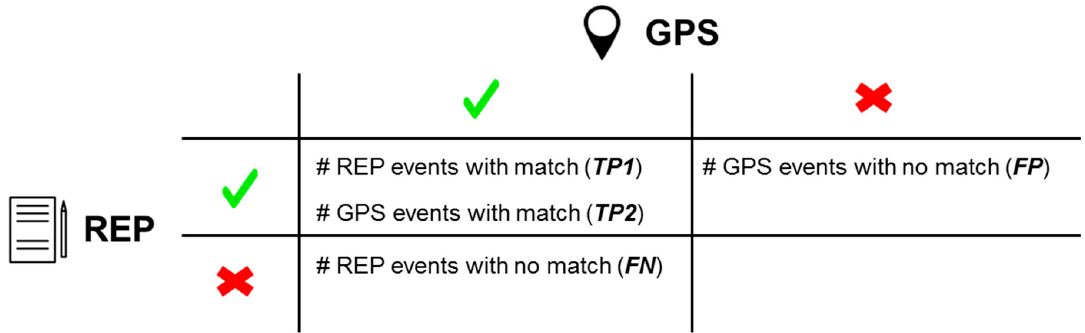
Figure A1. Confusion matrix for data with no ground truth.